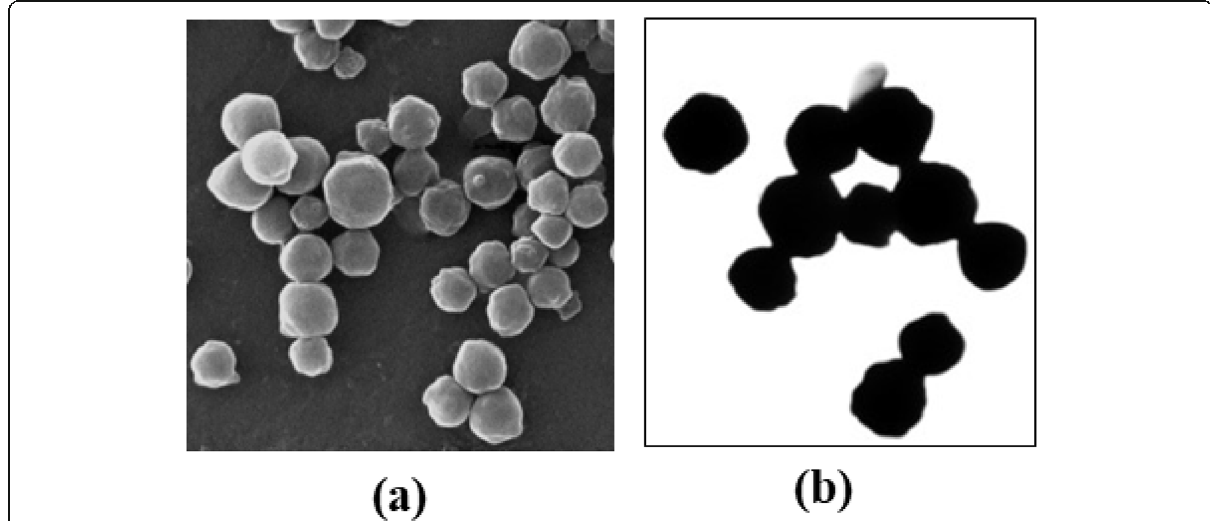
Fig. 4 a SEM and b TEM micrographs of viral occlusion bodies (OBs)